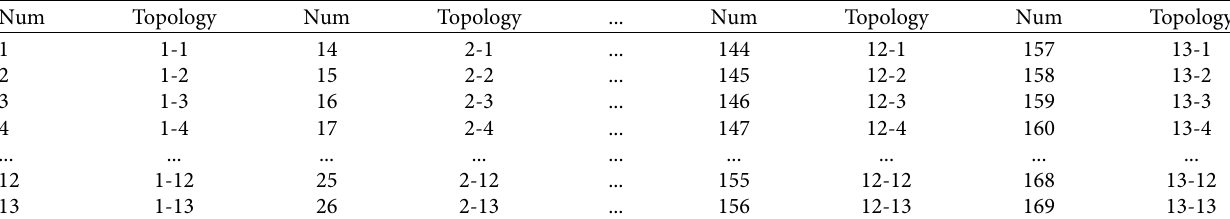
Table 2: Artificial neural network architectures trained.